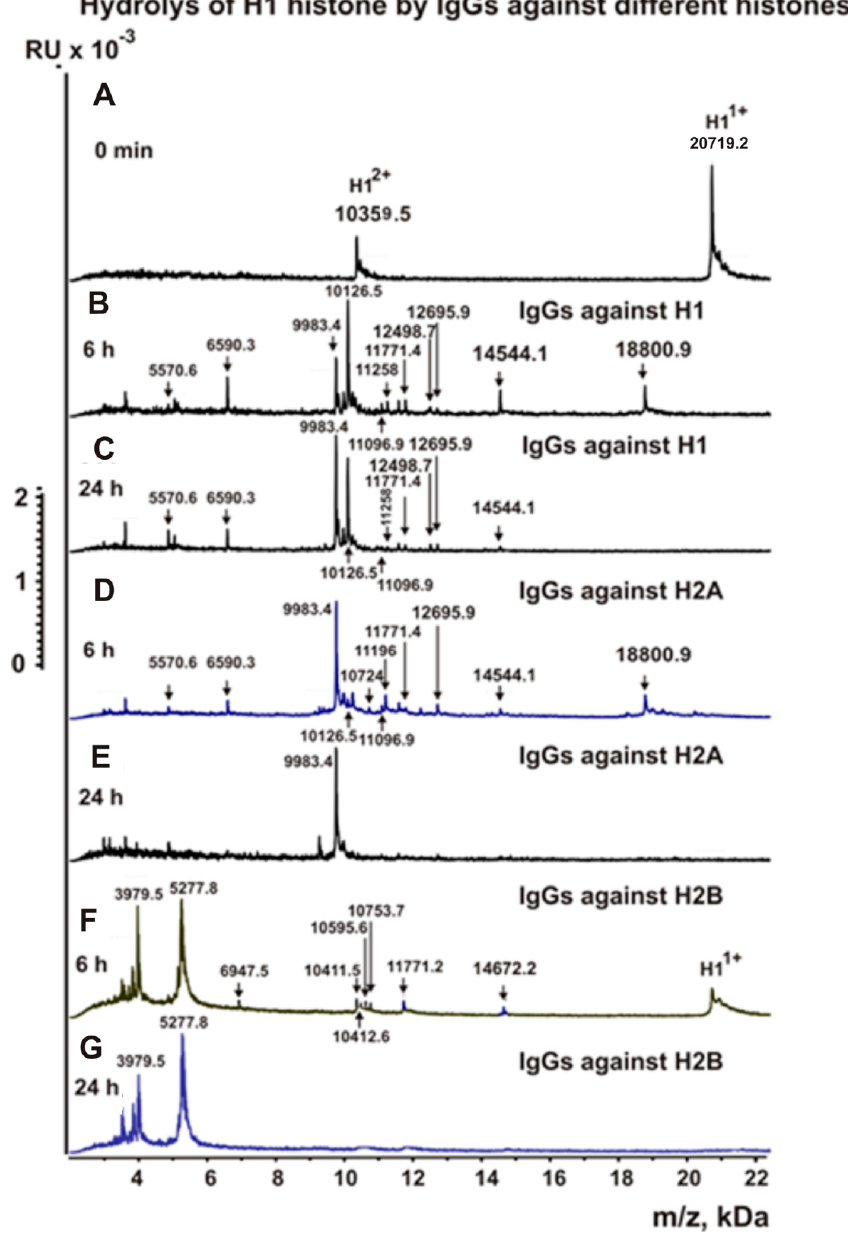
Figure 2. MALDI spectra ( A – G ) corresponding to hydrolysis of H1 histone (0.7 mg/mL) over time (0–24 h) in the presence of IgGs (0.04 mg/mL) against H1 ( B , C ), H2A ( D , E ), and H2B ( F , G ). The abzymes against histone H4 hydrolyzed H1 very slowly. Only after 24 h of in- cubation were several significant peaks of H1 hydrolysis by these antibodies found (Figure 3C,D). Ultimately, three reliably tested sites for hydrolysis of H1 by anti-H4 an- tibodies were identified. Two sites were classified mostly as minor sites (K127-A128, and K136-P137) and only T109-K110, the peak corresponding to which appears first, can be classified as a moderate hydrolysis site.